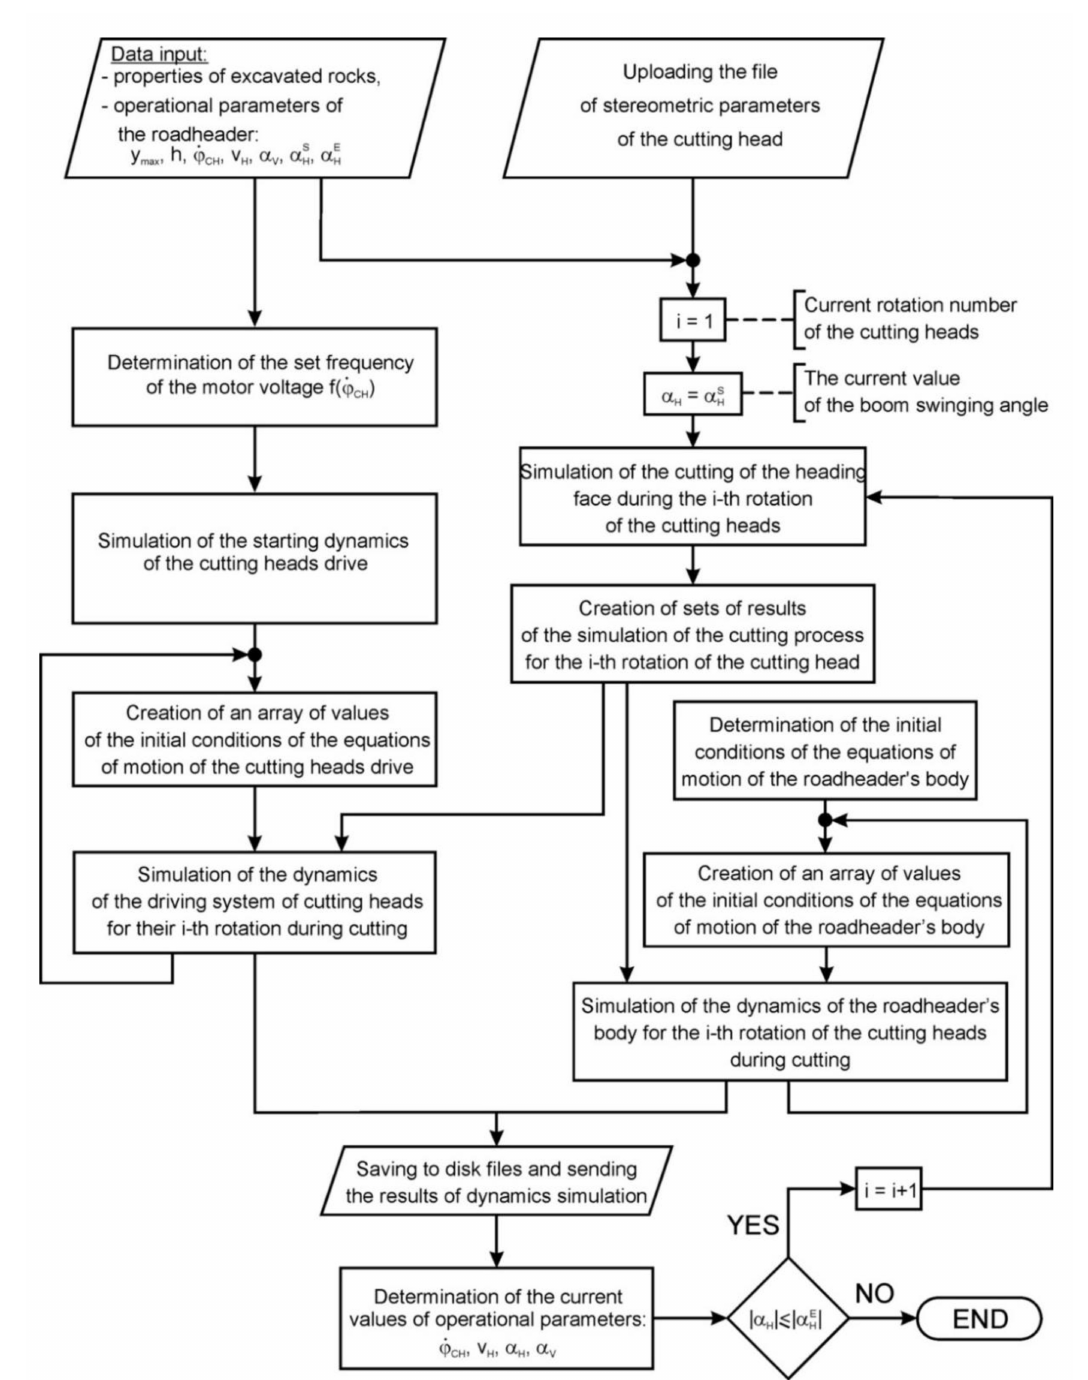
Figure 13. Algorithm of the roadheader dynamics simulation procedure in the Computer Simulation Module SIMCUT